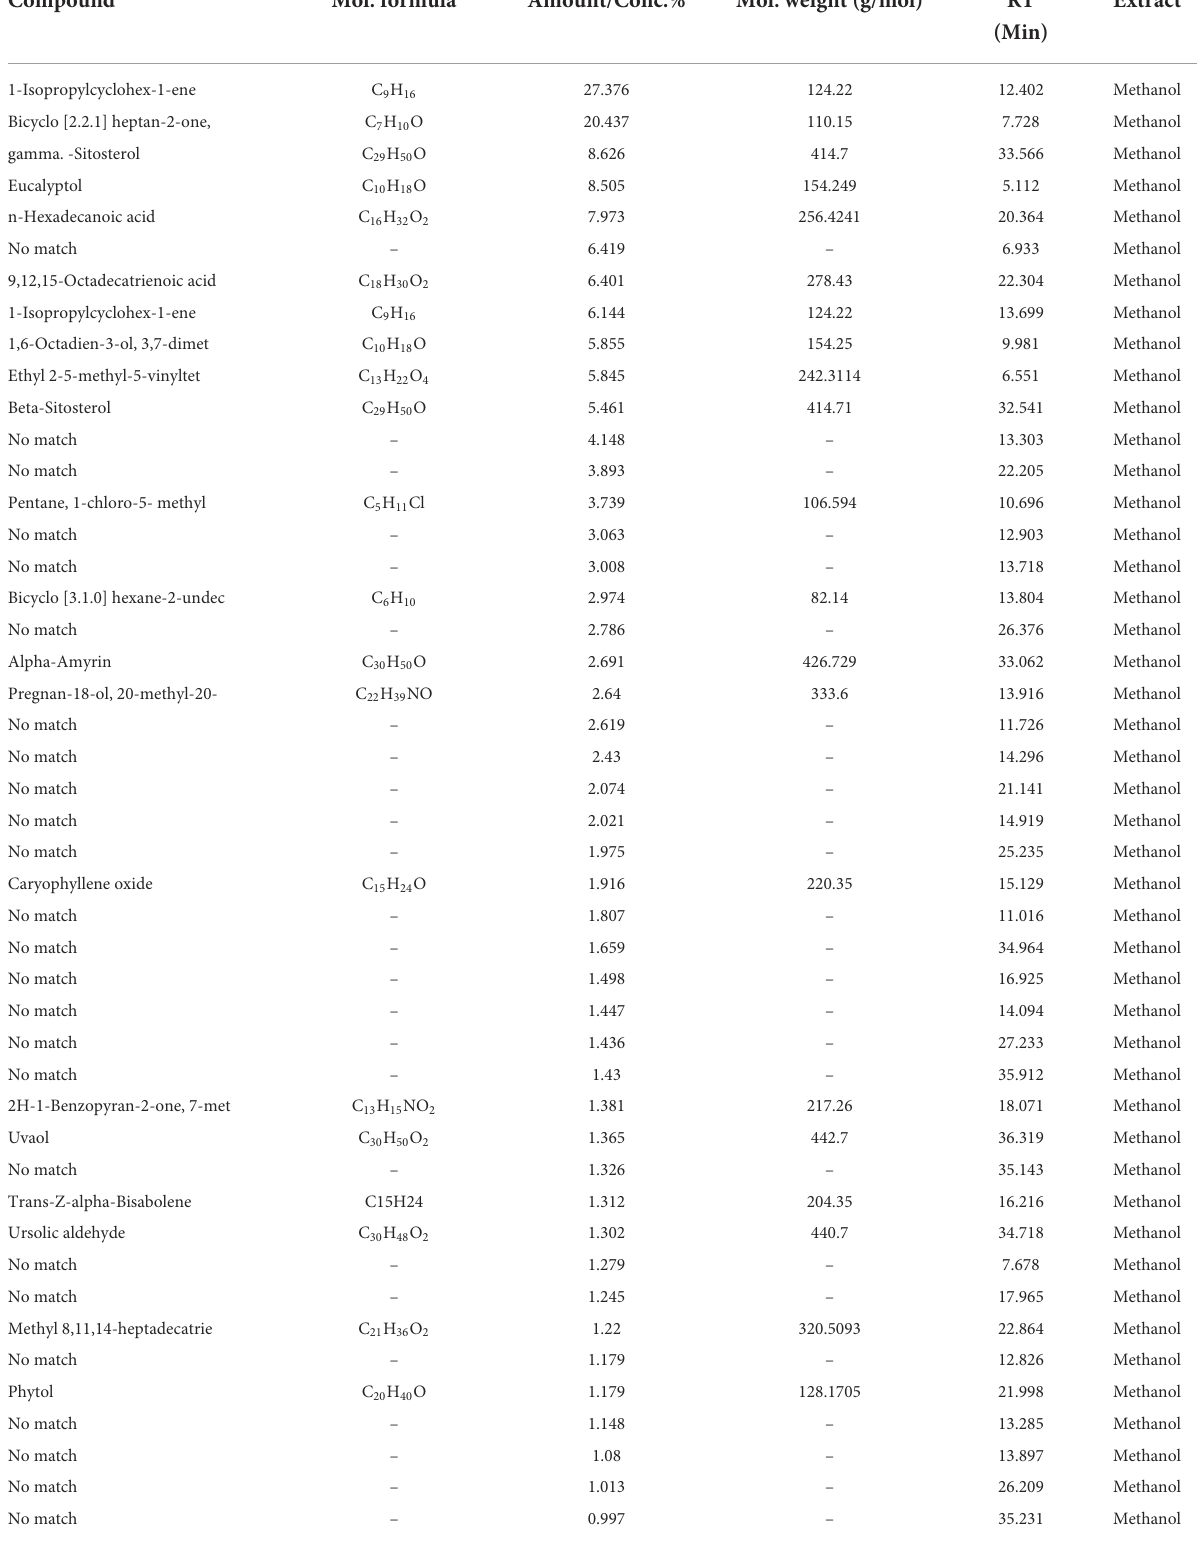
TABLE 2 GC/MS analysis of a methanol extract of N. cataria using NIST 17 Library showed (68 identified phytochemicals + 48 unmatched) chemicals, arranged according to concentration present.